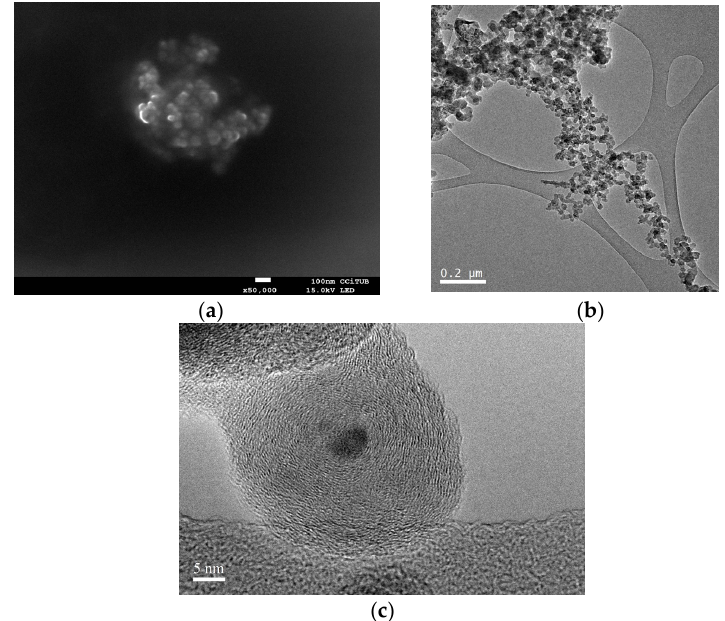
Figure 2. ( a , b ) SEM (scanning electron microscopy) and TEM (transmission electron microscopy) images of CEINPs (carbon encapsulated iron nanoparticles), respectively; and ( c ) HRTEM (high resolution transmission electron microscopy) image from a single iron core at carbon shell nanostructure, the iron core is visible in black spot.